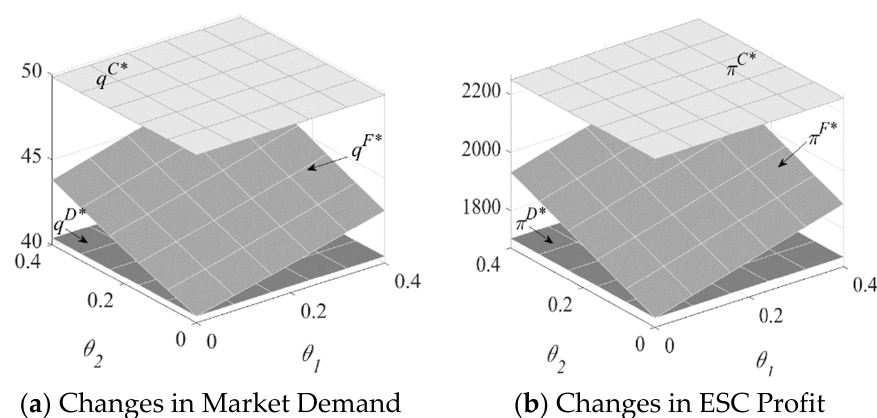
Figure 4. Changes in market demand and ESC profit with 𝜃 (cid:2869) and 𝜃 (cid:2870) .